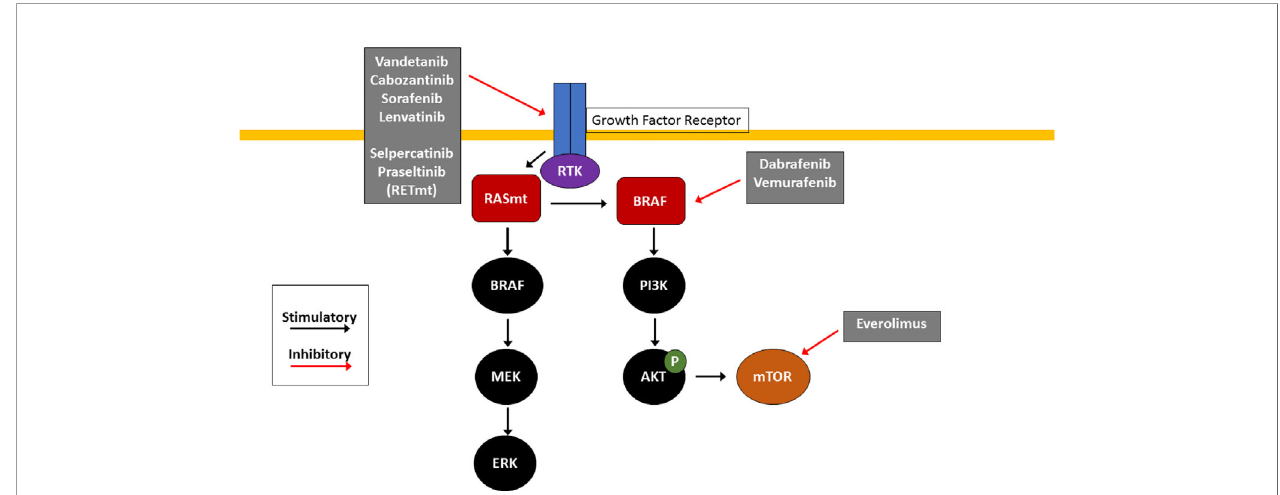
FIGURE 1 | Molecular Pathogenesis of Thyroid Cancer. RAS/RAF/MEK and PI3K/AKT/mTOR pathways are key signaling pathways in thyroid cancer pathogenesis. Mutations in RAS (RASm) or BRAF result in constitutive activation of the MAPK pathway, causing downstream activation of the MAPK and PI3K pathways which promotes cell growth and tumorigenesis. Effective agents include multikinase inhibitors (cabozantinib, vandetanib, sorafenib and lenvatinib) which inhibit receptor tyrosine kinases (RTK) at the cell surface, selective RET inhibitors (selpercatinib and pralsetinib) which inhibit mutant RET RTK (RETm), BRAF V600E inhibitors (dabrafenib and trametinib) and the mTOR inhibitor everolimus. These small molecule inhibitors are used clinically for treatment of RAIR TC with the goal of arresting uncontrolled